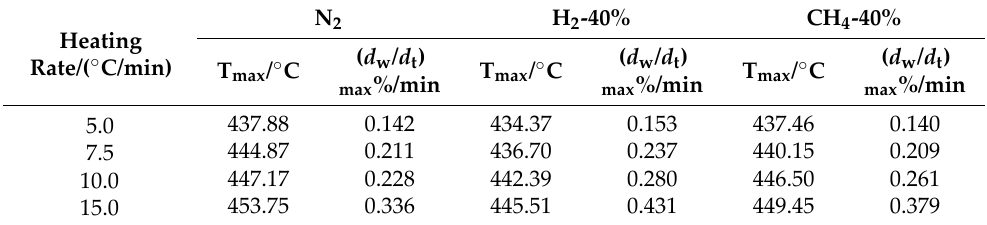
Table 3. Pyrolysis characteristic parameters of coal samples at different heating rates.